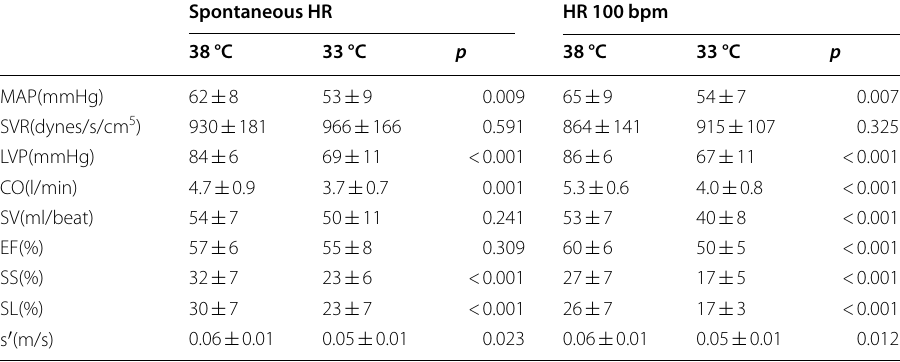
Table 1 Haemodynamic